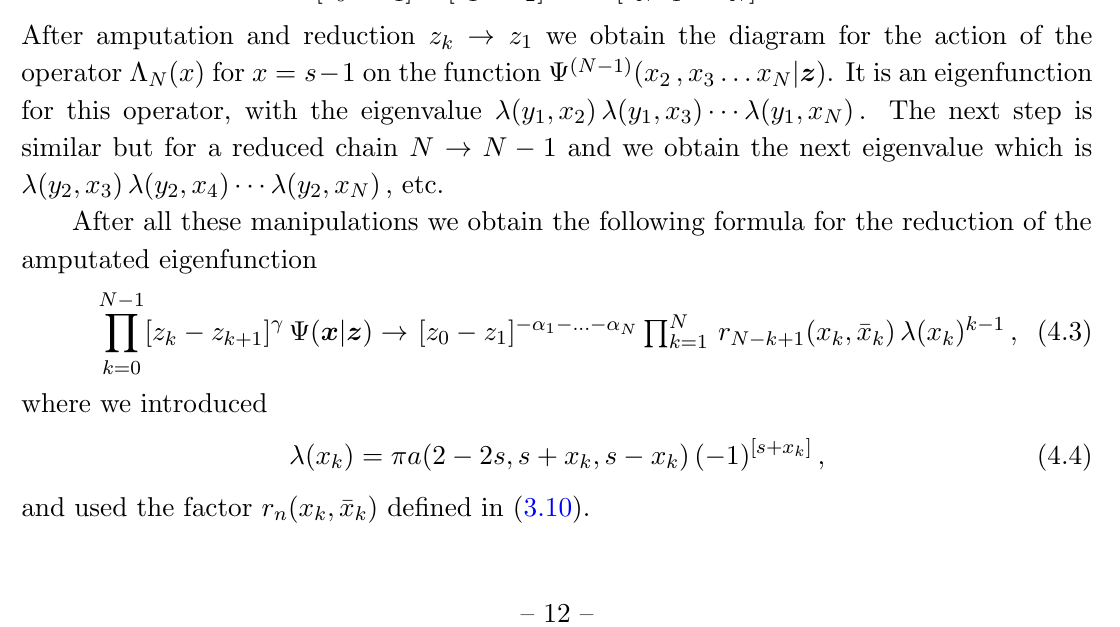
z 0 )(cid:3) 3 ( y 3 z 0 )(cid:3) 3 ( y 4 j j s 1, or (cid:12) k ! (cid:0)